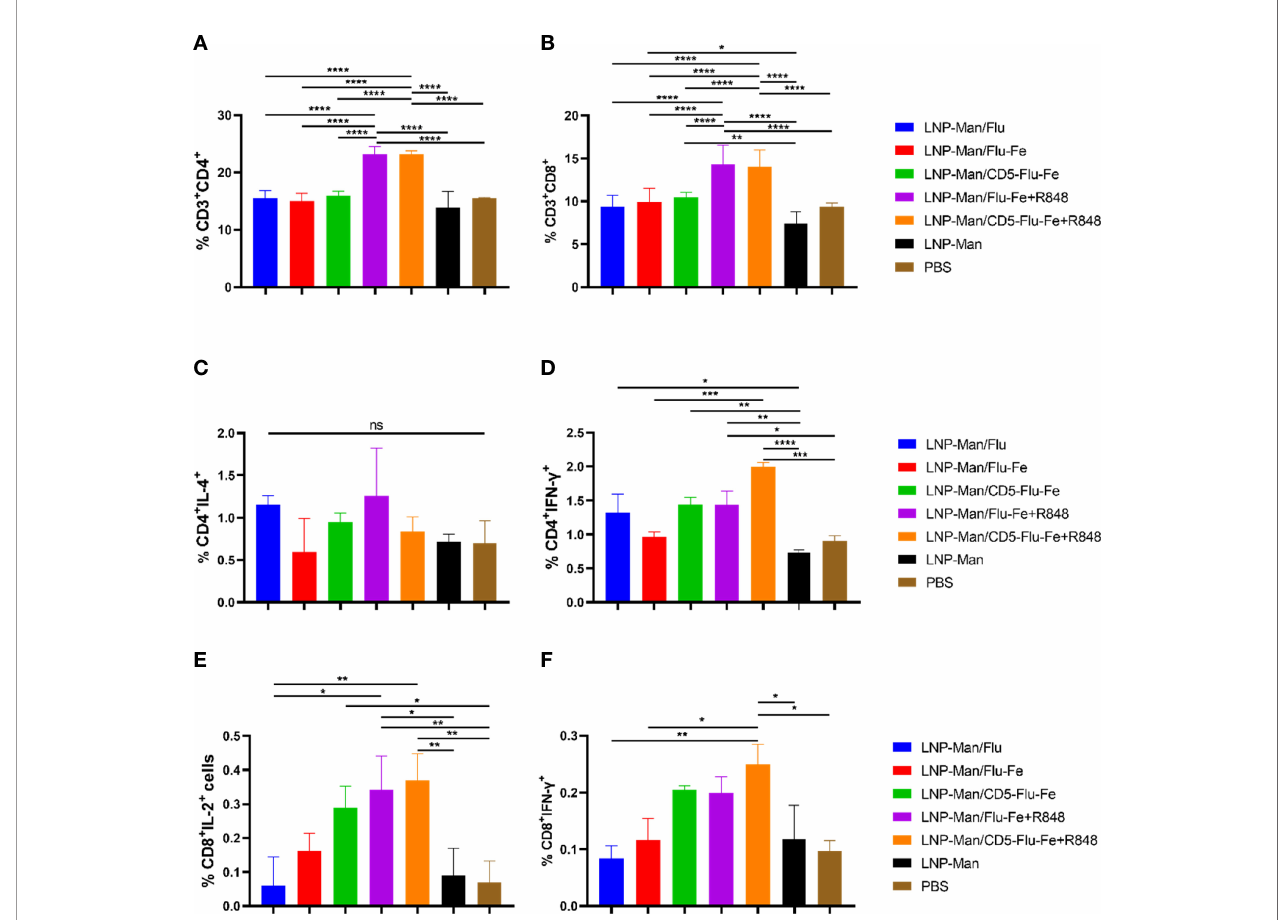
FIGURE 5 | Antigen-speci fi c T-cell responses in the spleen lymphocytes of C57BL/6 mice. On the 56th day after the fi rst immunization, the proportion of antigen- speci fi c CD4 + (A) or CD8 + (B) T cells was determined by fl ow cytometry analysis on splenocytes stimulated in vitro with M2e+HA2 peptides. Antigen-speci fi c cytokine + CD4 + T-cell subsets were identi fi ed as T h1 or T h2 depending on the intracellular cytokines, such as IL-4 (C) and IFN- g (D) . Antigen-speci fi c cytokine + CD8 + T-cell subsets were identi fi ed on the basis of the combination of IL-2 (E) and IFN- g (F) . Data were shown as mean ± SDs and were analyzed by ordinary one-way ANOVA multiple comparisons (n=3, ns p > 0.05; *p < 0.05; **p < 0.01; ***p < 0.001; ****p <